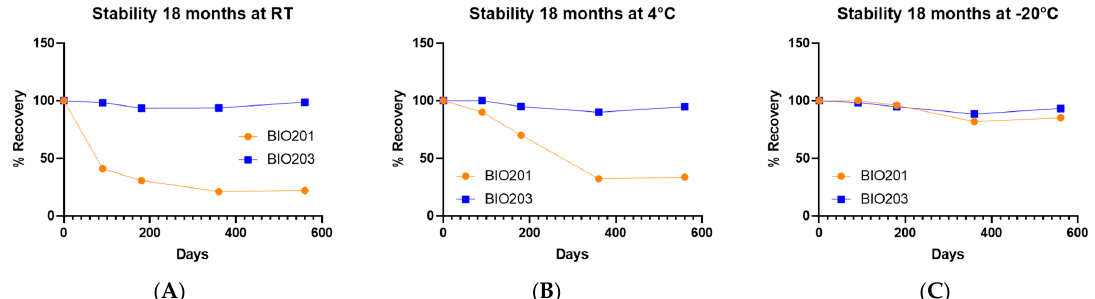
Figure 1. Compared stability of powders of BIO203 and norbixin (BIO201) at RT, 4 °C, and − 20 °C for a period of 18 months. ( A ) Percent of recovery of BIO203 (in blue) and BIO201 (norbixin in or- ange) at room temperature (RT). ( B ) Percent of recovery of BIO203 and BIO201 at 4 °C and ( C ) at − 20 °C.